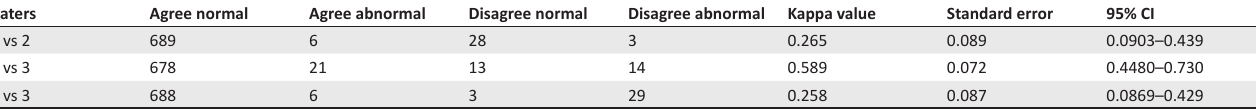
TABLE 1: Summary of Kappa statistics of the reviewers done on the CECT dataset before consensus was reached to determine inter-rater agreement. Raters